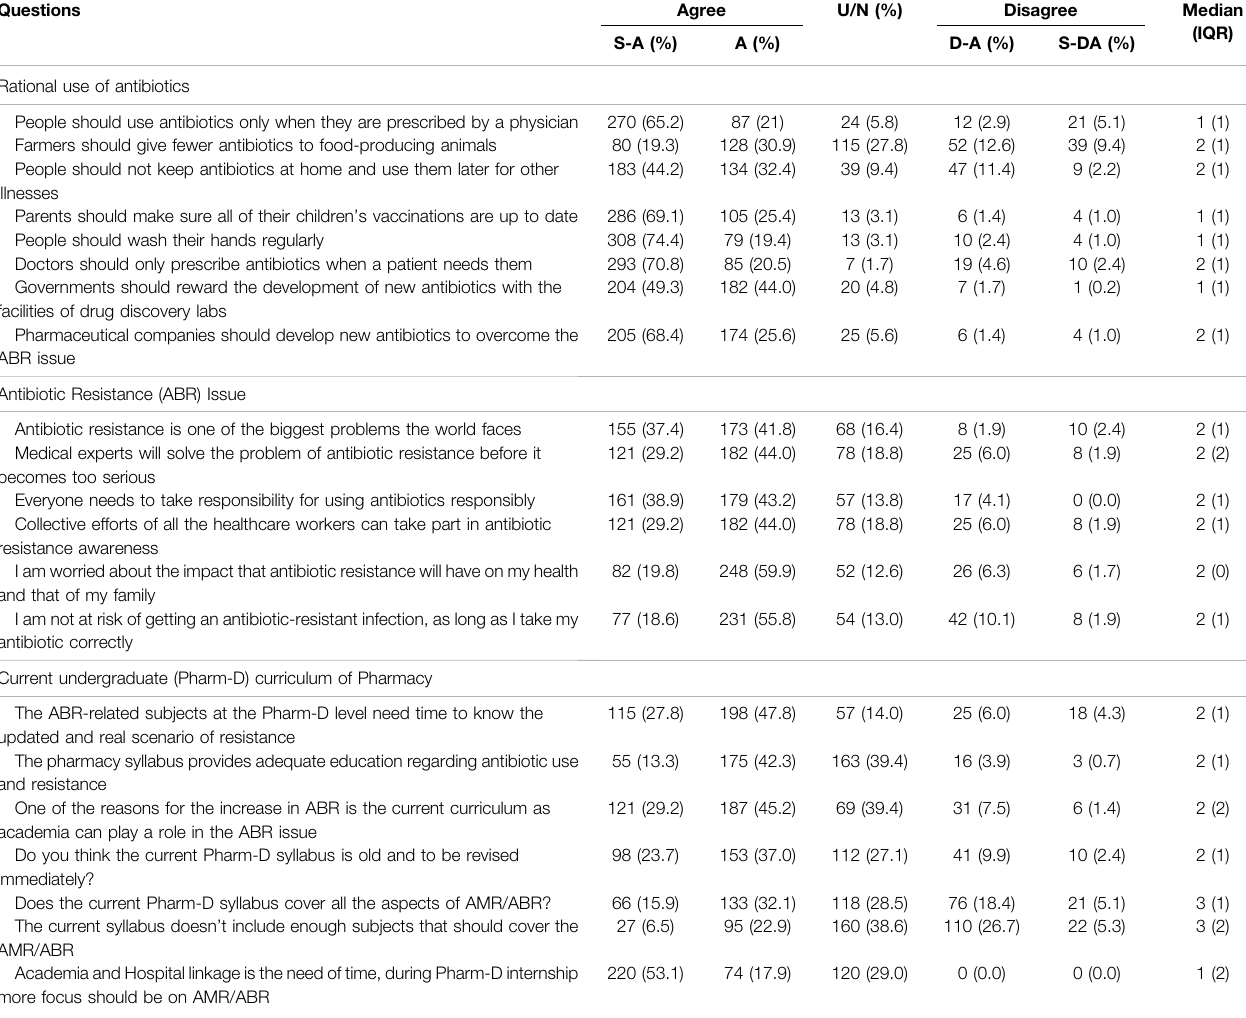
TABLE 5 | Exploring antibiotics knowledge and antibiotic